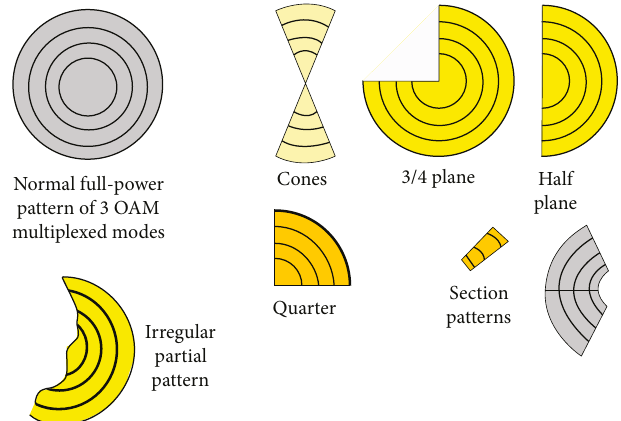
Figure 1: Scenarios for reducing the receiving